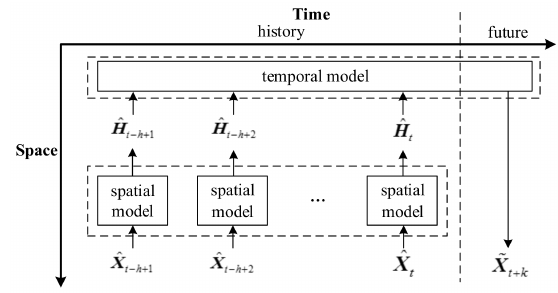
Figure 2. The mode of wind speed prediction with spatio–temporal correlation.